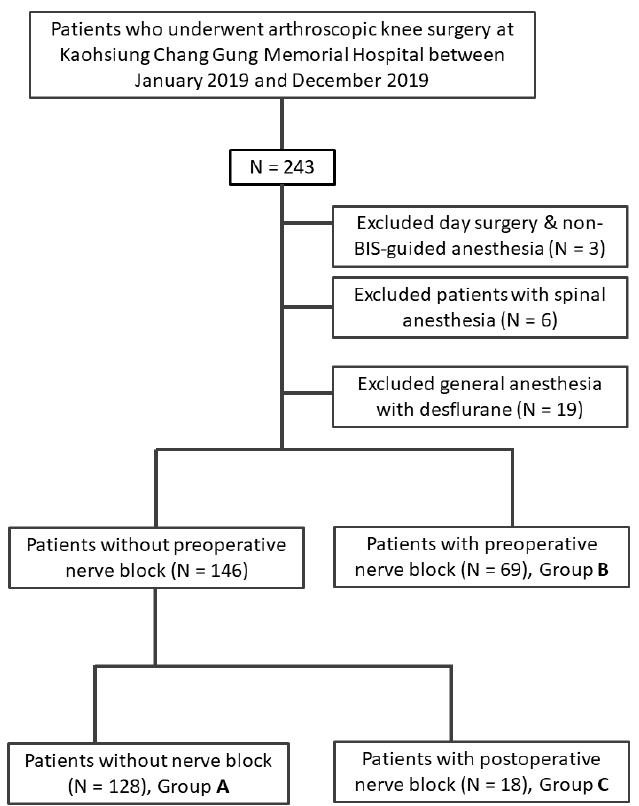
Figure 1. Flow chart of allocation of patients underwent arthroscopic knee surgery into Group A (non-ACB), Group B (preoperative ACB) and Group C (postoperative ACB).